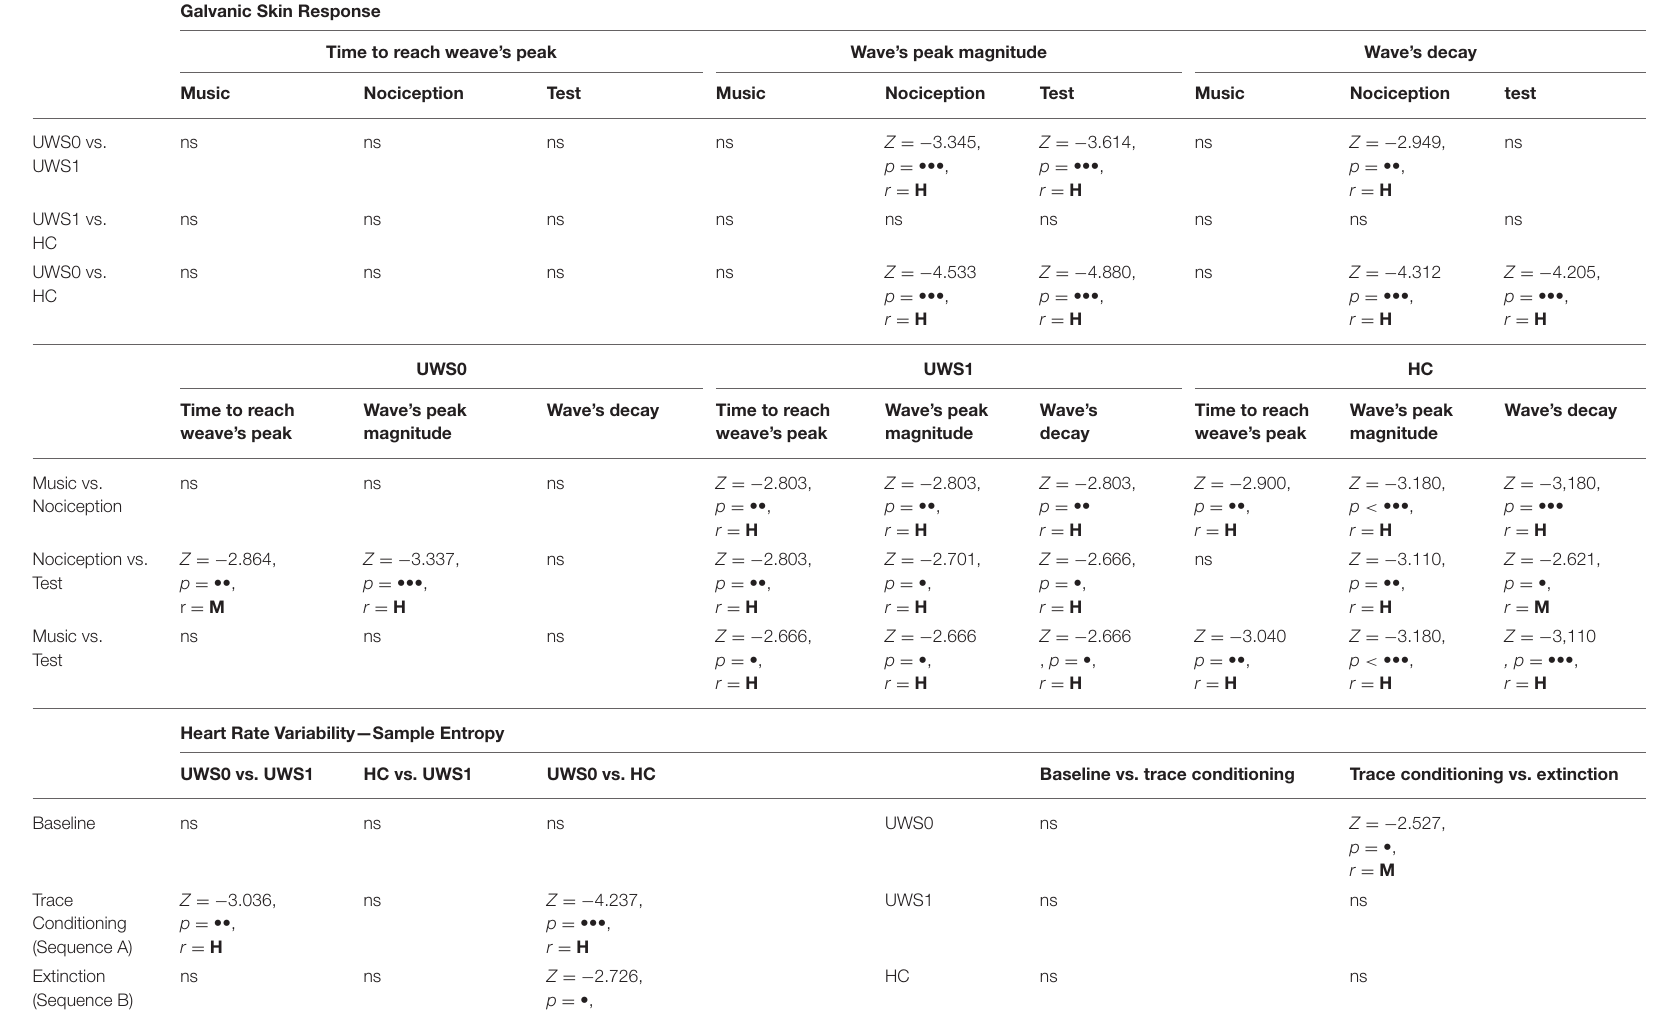
TABLE 2 | Statistic results for GSR in MUS4, NOC3, and NOC * and for SampEn in Baseline, sequence A and sequence